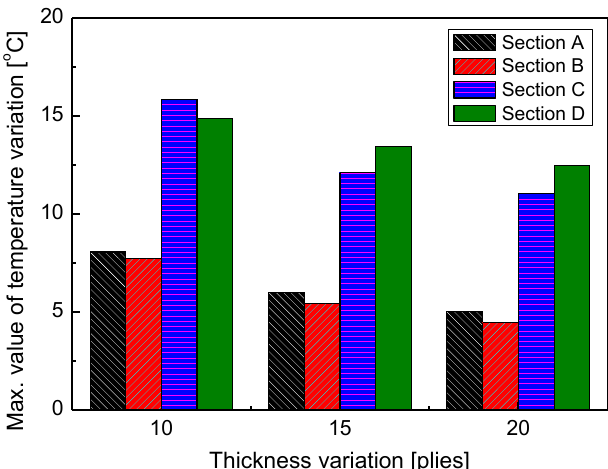
Figure 11. Maximum temperature difference through thickness with thickness variations.